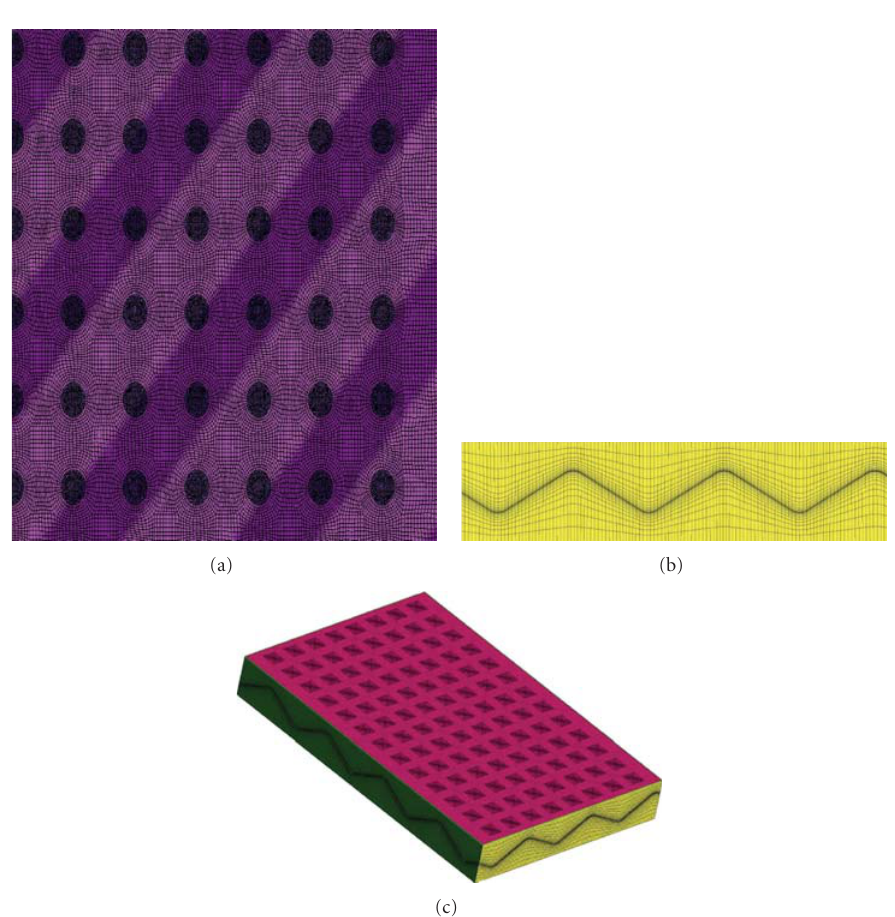
Figure 4: Meshes shown in detail for corrugated sheet of packing used in this work. (a) Top view. (b) Side view. (c) Isometric